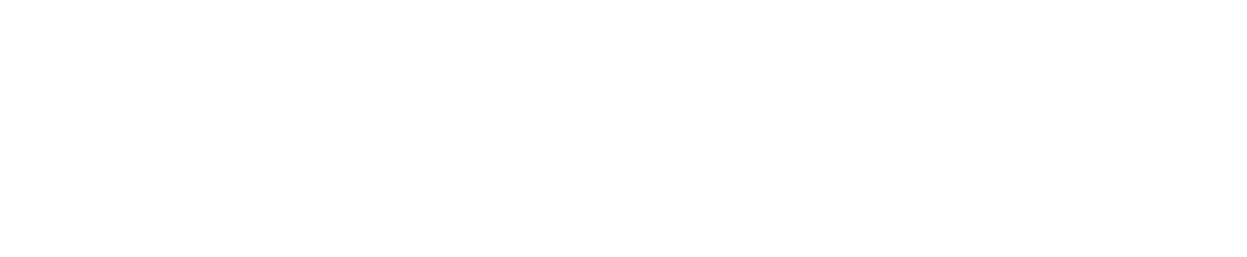
observed on the 50 th day (Table I). In this case, the damage was not very severe, and the major part of the cells remained almost